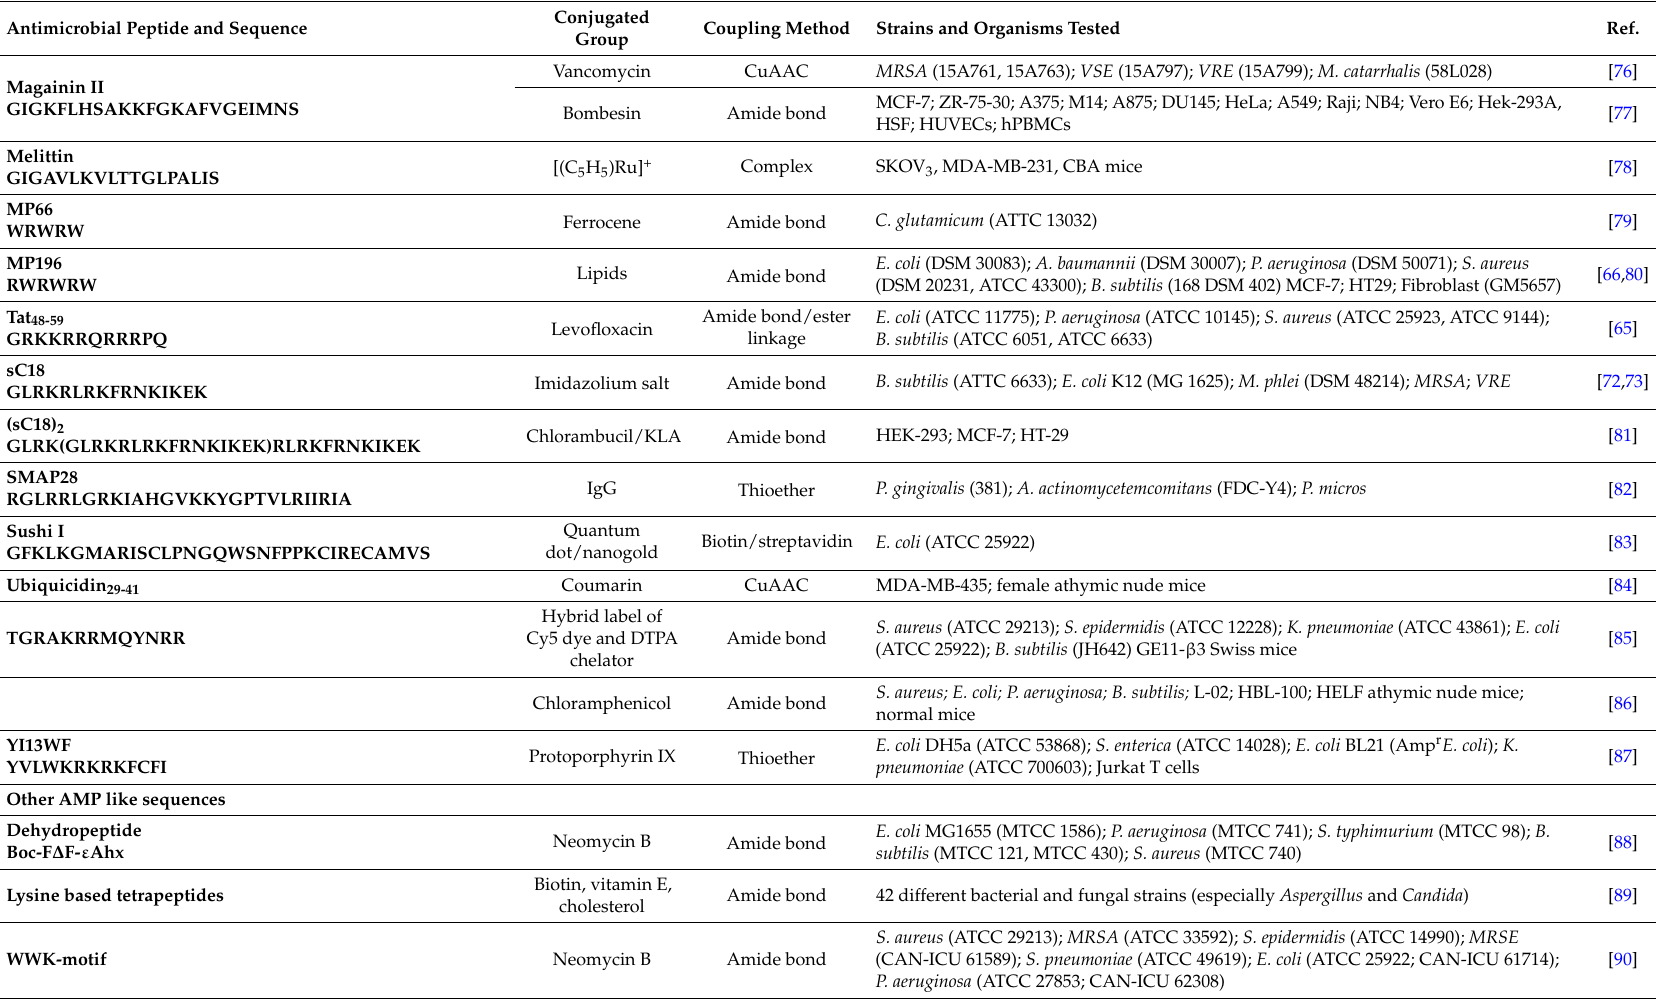
Antimicrobial Peptide and